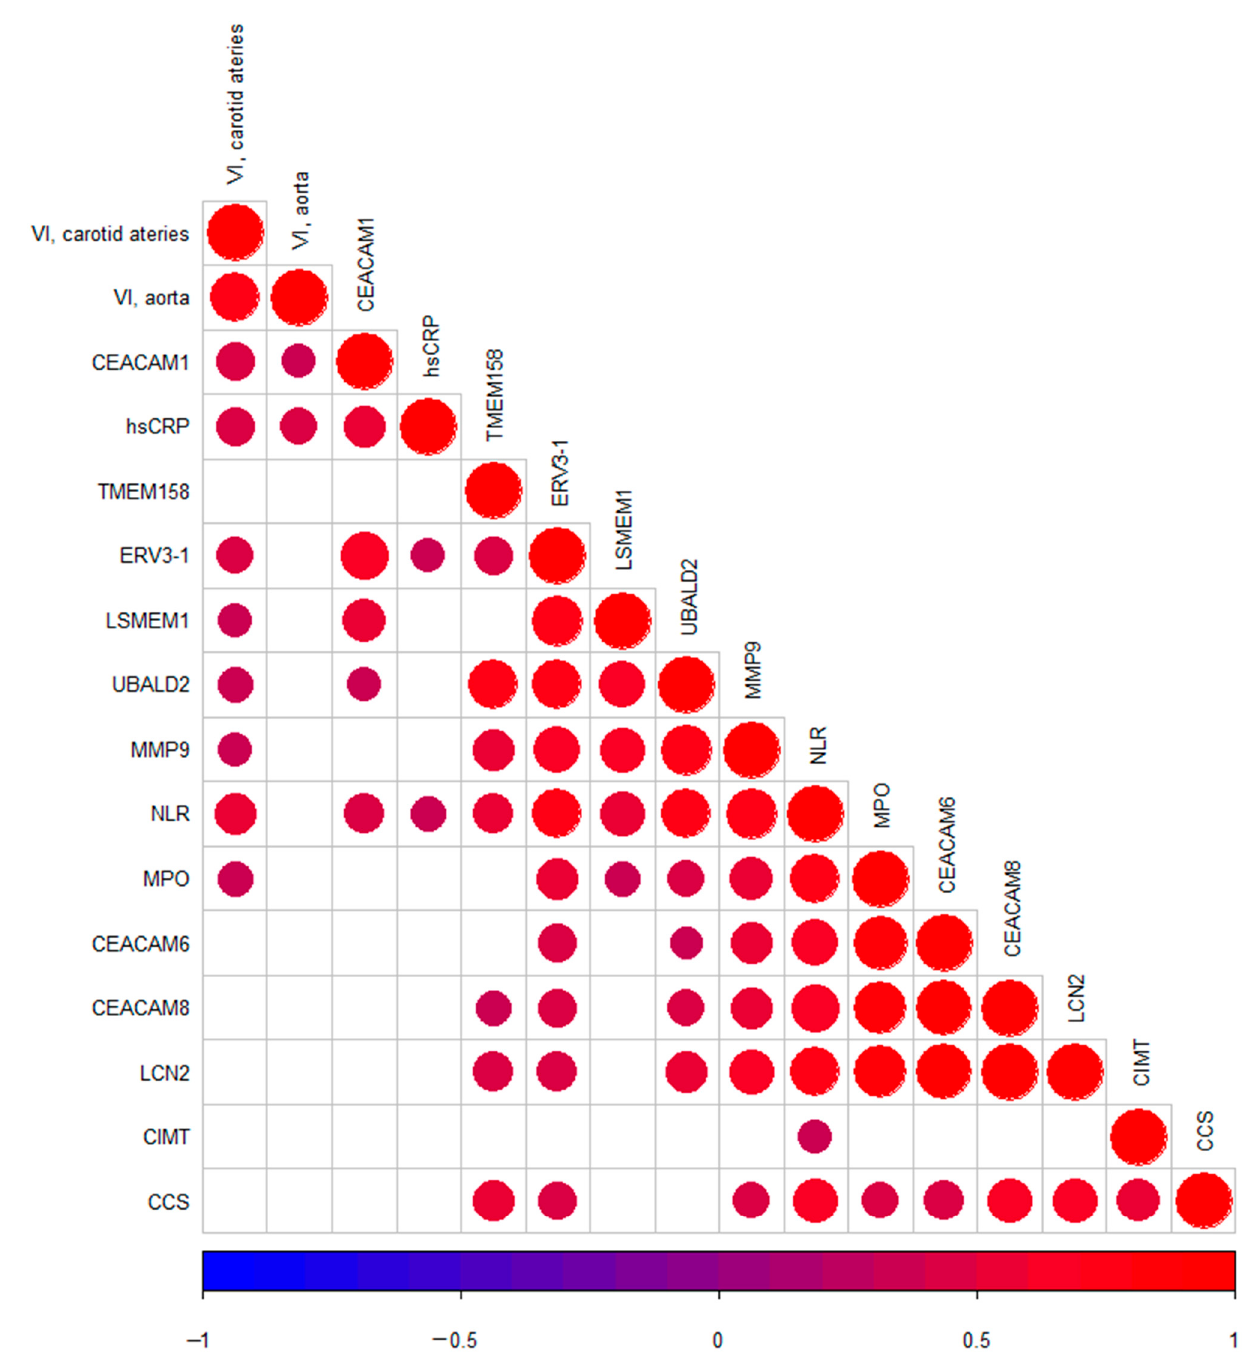
Figure 3. Correlation matrix of DEGs of special interest, non-traditional CVD risk factors and subclinical measures of CVD. Circles indicate a significant correlation ( p < 0.05). The size of the circles as well as their colors indicates the magnitude of Pearson’s correlation coefficient. NLR ( n = 38); hs-CRP ( n = 38); CIMT ( n = 37); CCS ( n = 25); VI (carotid arteries, n = 36; aorta n = 34).